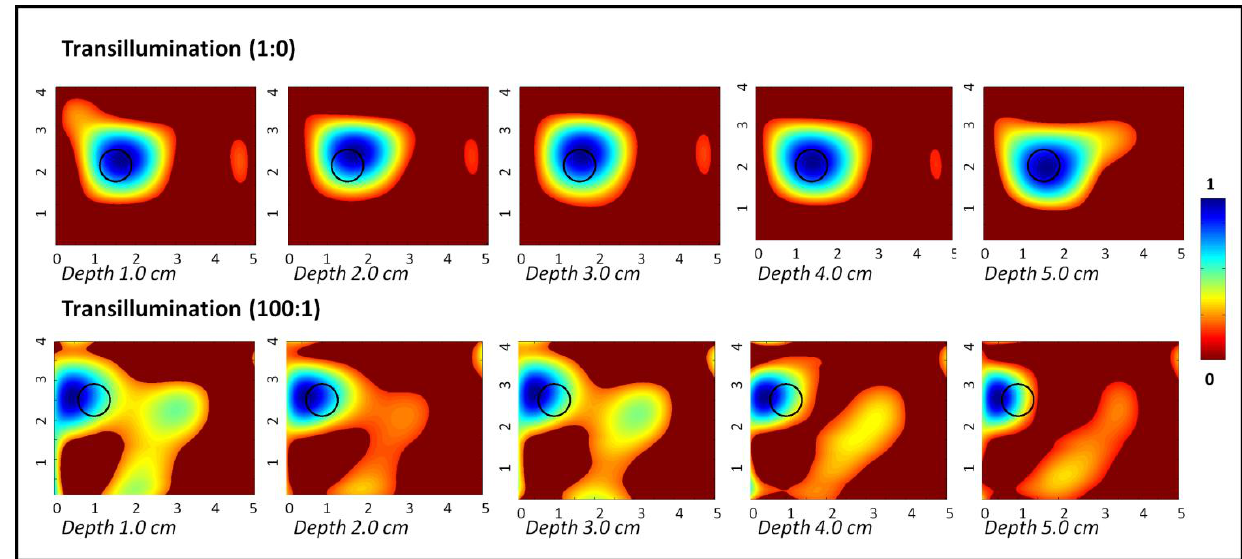
transilluminated reflectance imaging studies of a 0.45 cc spherical target at 1:0 and 100:1 T:B India Ink contrast, located at various depths. The black hollow circle represents the true 2D target location.